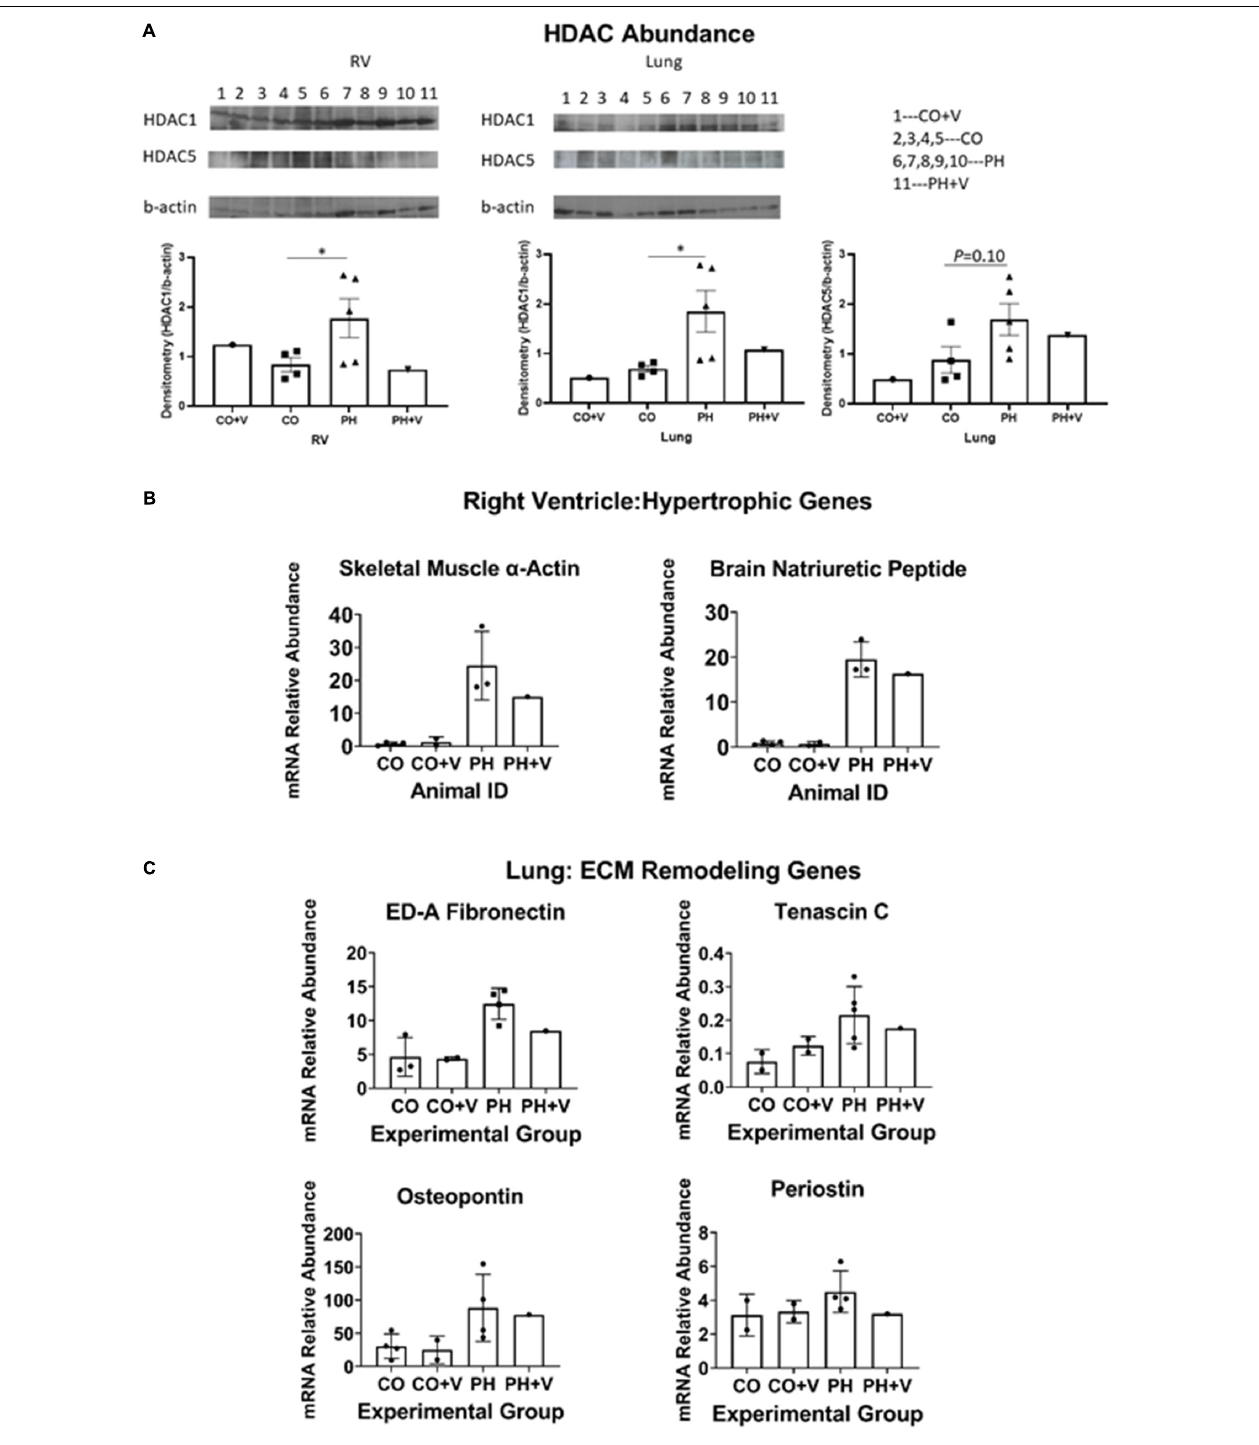
FIGURE 3 | Molecular correlates of vorinostat treatment. (A) Immunoblotting HDAC abundance. RV and lung homogenates were prepared and HDAC abundance was determined by immunoblotting as described in section “Materials and Methods.” Additional untreated control and hypoxic animals were analyzed in parallel for comparison. Protein abundance was quantitated densitometrically relative to beta-actin. ∗ p < 0.05 vs. control (unpaired two-tailed t -test). (B) Representative genes in RV hypertrophic remodeling. Abundances of indicated mRNAs were quantitated by real-time PCR as described in section “Materials and Methods.” Animals used in the present study were analyzed together with samples from additional untreated hypoxic and normoxic calves ( n = 4 each) that were managed according to the same animal protocols described in section “Materials and Methods,” and studied around the same period of time. (C) Representative genes in pulmonary remodeling. Determinations were performed as described for (A) and in section “Materials and Methods.”